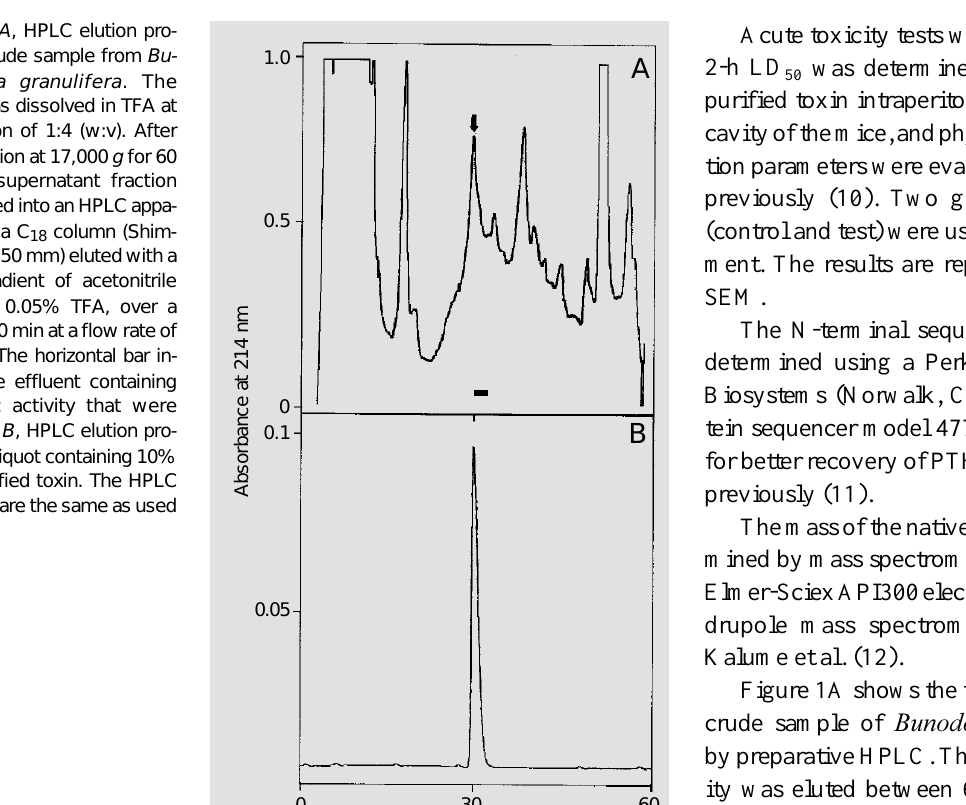
conditions are the same as